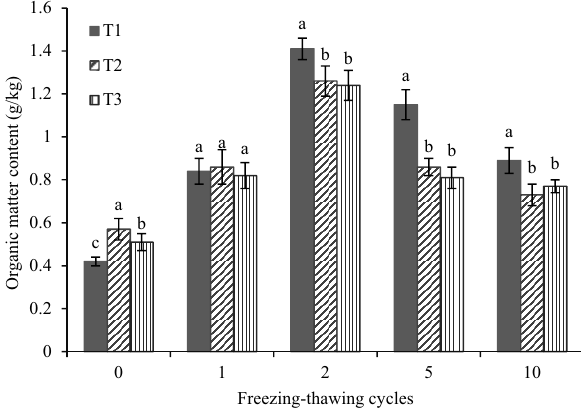
Figure 1: Changes of organic matter content in reconstructed soils with di ff erent freezing – thawing cycles. Letters above the bars indicate the signi fi cance of the di ff erences ( at 0.05 level ) between treatments; the small bar shows standard deviation. Bars in dif - ferent treatments but with the same letters are not signi fi cantly di ff erent at P >